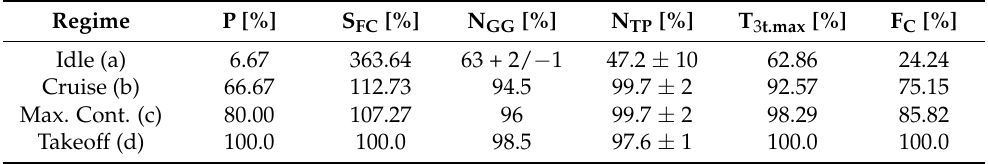
Table 6. The percentage variation of the main engine parameters.